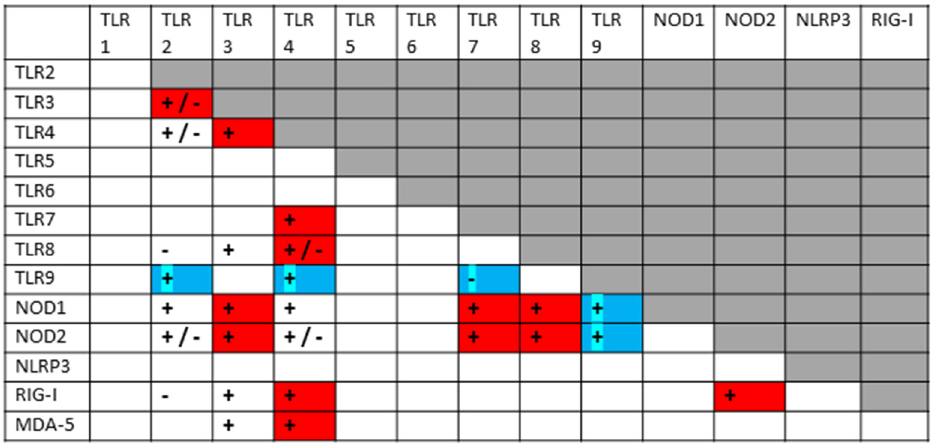
Figure 10. Predicted synergisms (+) and antagonisms ( − ) resulting from SARS-CoV-2 spike protein vaccine activation of innate receptors in the presence of a bacterial infection such as Staphylococcus or Streptococcus. The blue entries indicate additional synergisms and antagonisms that would result if the spike protein vaccine were delivered using an adenovirus vector. Interactions were predicted by mapping Figure 3 (literature review of innate receptor activation) onto the template provided by Figure 2 (summary of known innate receptor synergisms and antagonisms). Red entries indicate extracellular (“bacterial antigen”) receptor synergisms with intracellular and endosomal (“viral antigen”) receptors.